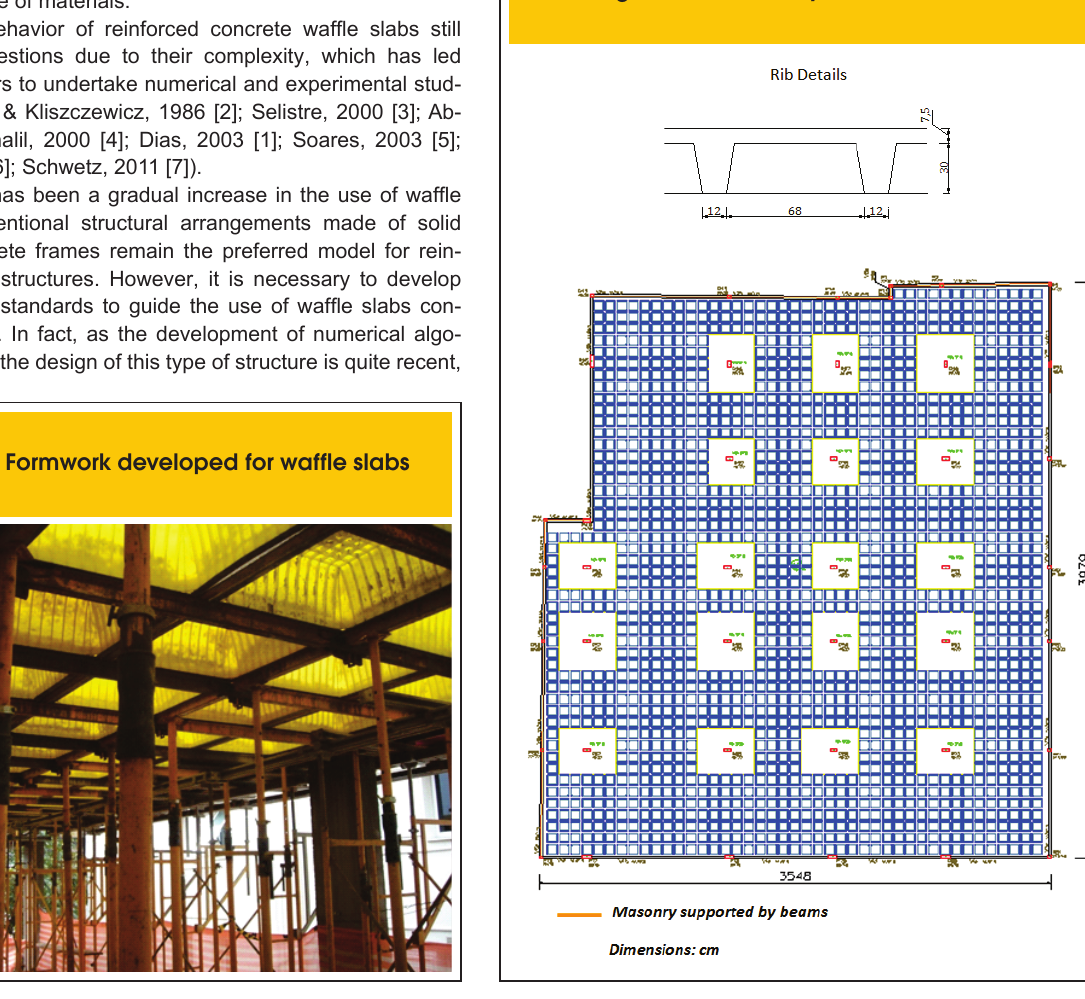
Figure 3 – Geometry of the waffle